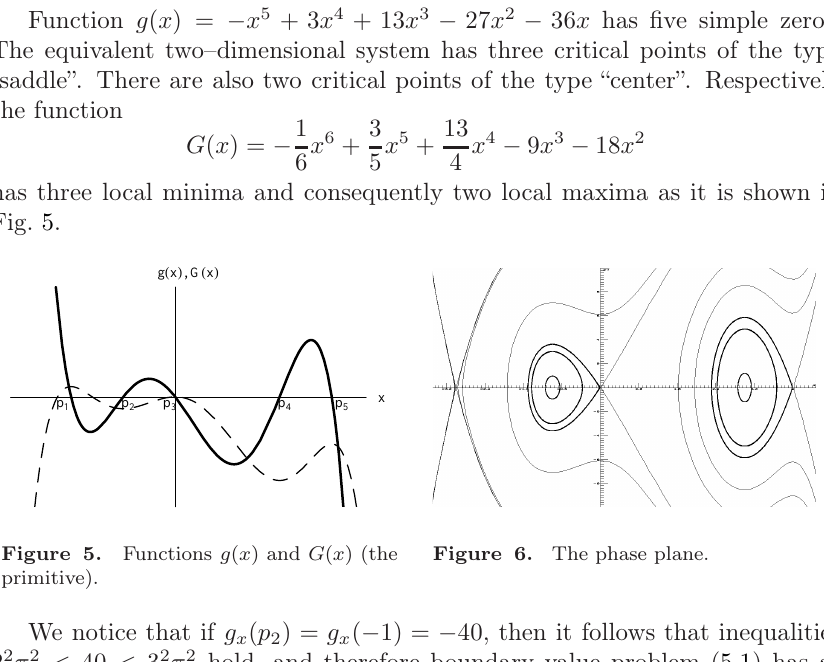
Figure 5. Functions g ( x ) and G ( x ) (the primitive).